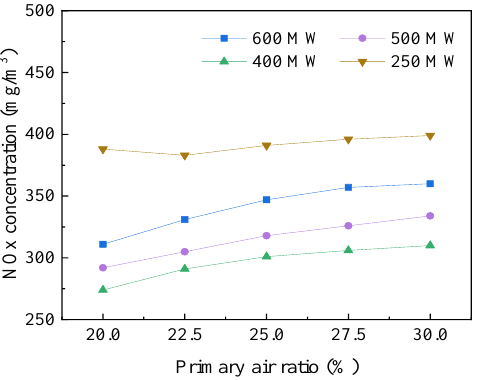
Figure 14. Variation in NOx concentration at economizer outlet with the primary air ratio.